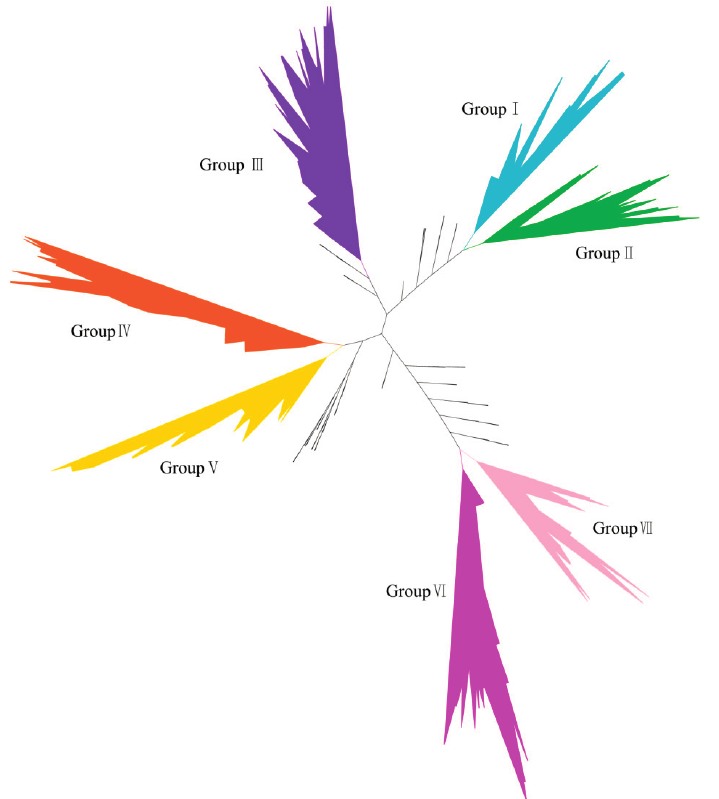
Figure 1. Phylogenetic relationships of 365 plant homologous to E6-associated protein (E6-AP) carboxyl terminus (HECT) genes. The maximum likelihood unrooted tree is shown, and the main branches corresponding to the seven groups are indicated with different